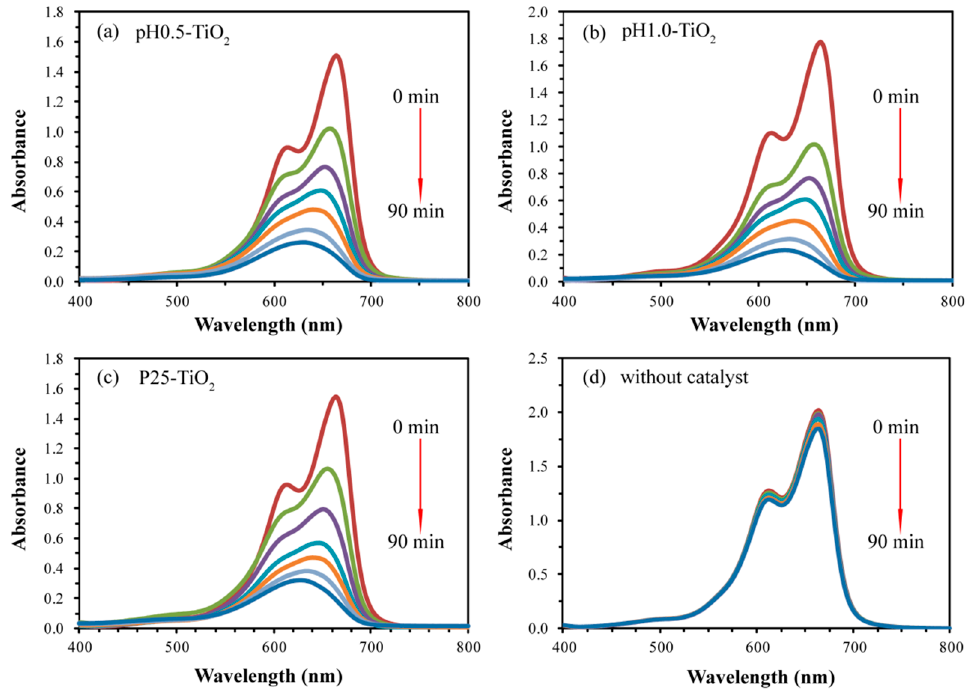
Figure 5. UV-vis spectral changes of MB solutions as a functional of UV irradiation time in the presence of ( a ) pH0.5-TiO 2 , ( b ) pH1.0-TiO 2 , and ( c ) P25-TiO 2 , and ( d ) absence of any photocatalysts.